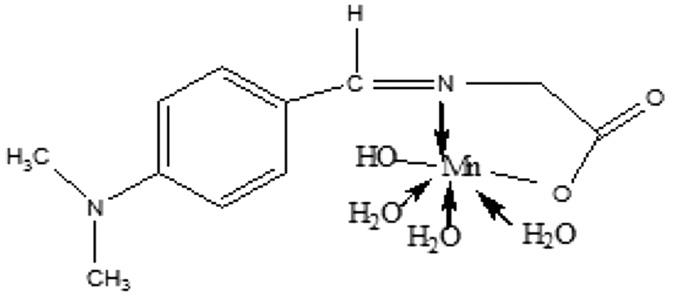
Chemical structure of MDLA [Mn L (H2O) 3(OH)].